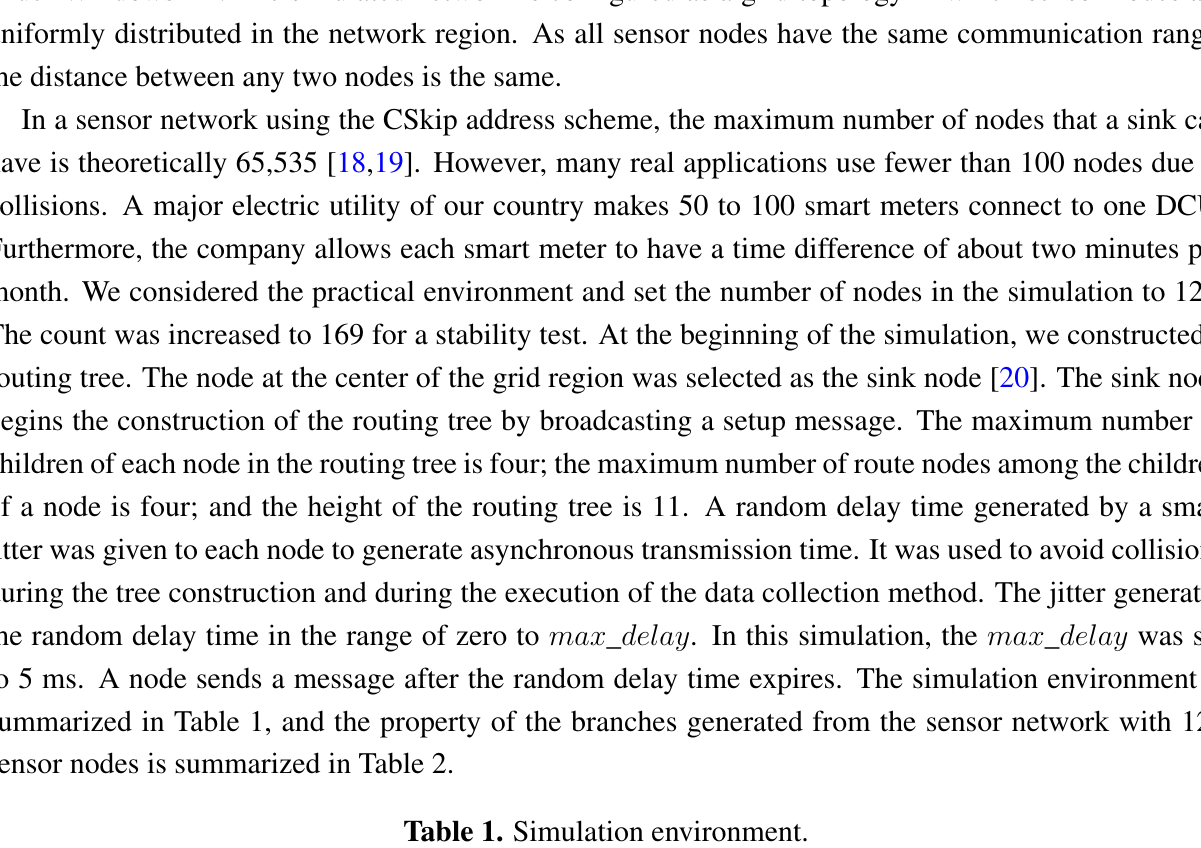
Table 1. Simulation environment.